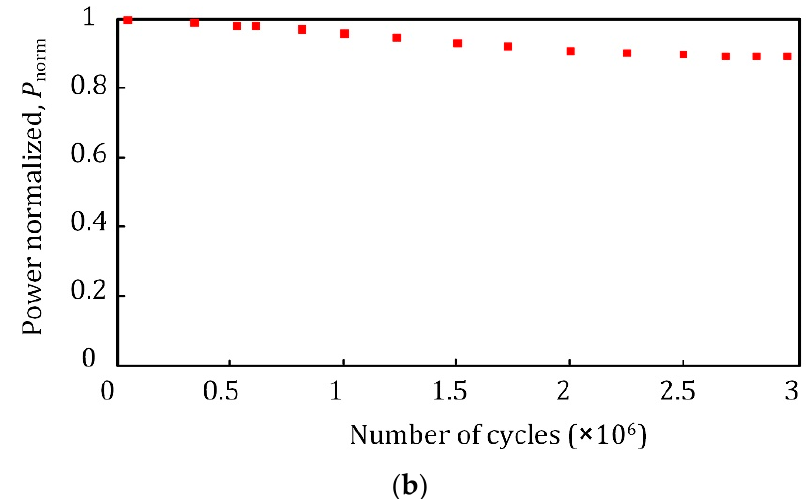
Figure 20. The effect of ( a ) temperature [42] and ( b ) long-term fatigue cycles [43] on the piezoelectric transducer output.